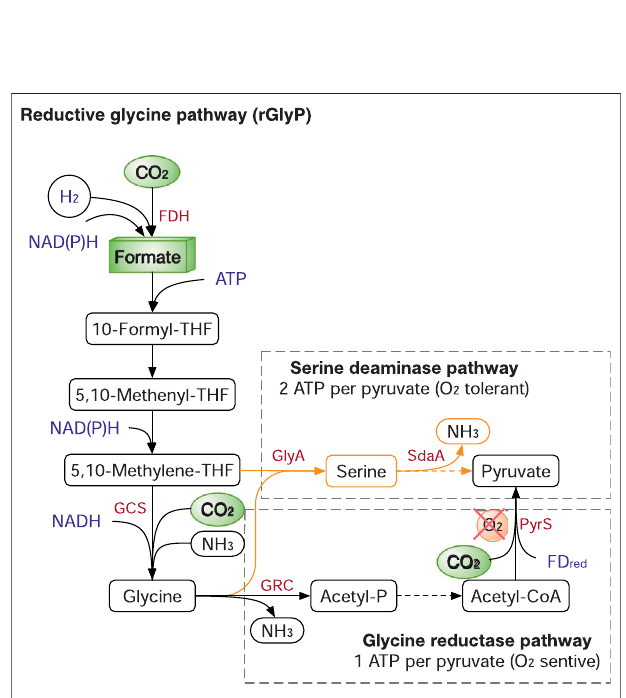
Frontiers in Bioengineering and Biotechnology |